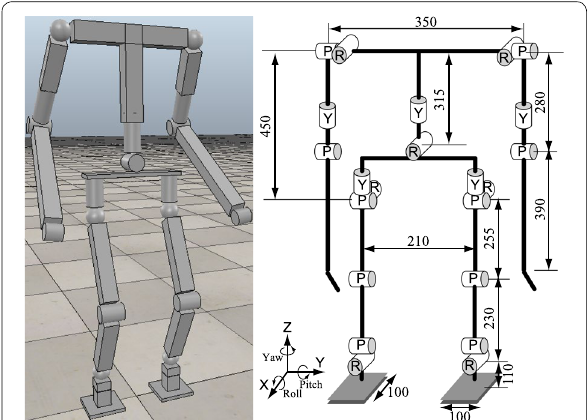
Fig. 7 Modified model of Gorilla Robot III for simulation its weight is about 22 kg; its height is about 1 m; total DOFs are given as 22